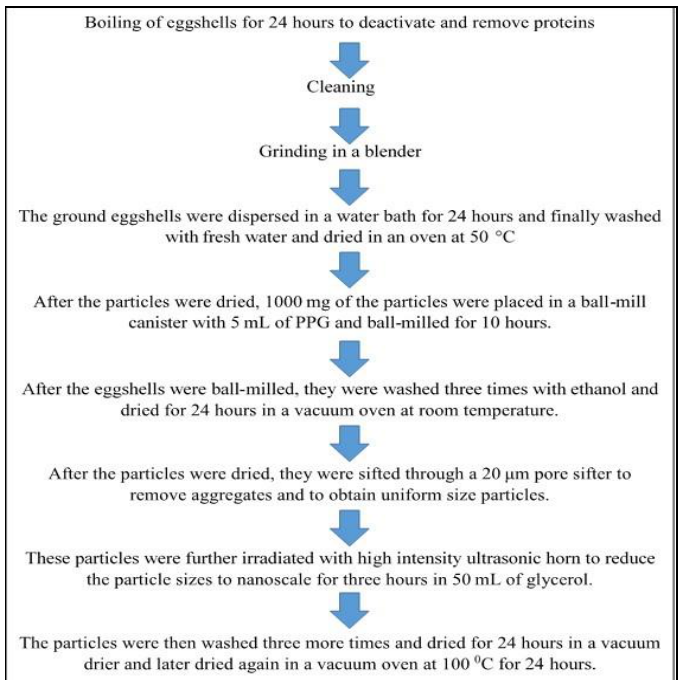
Figure 3. Steps involved in the synthesis of calcium carbonate nanoparticles from eggshell waste.